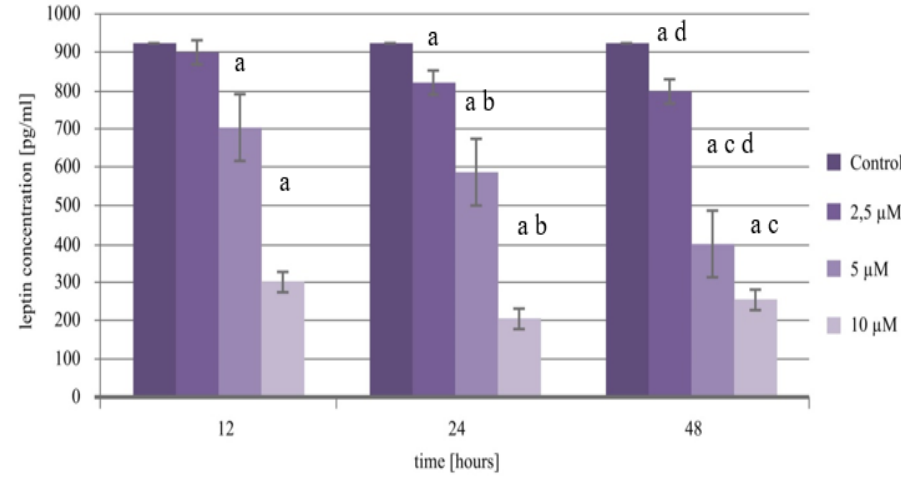
Figure 5. Changes in the expression of leptin in the endometrial cancer cell line treated with cisplatin, obtained by the ELISA assay (a—statistically significant differences in the expression of leptin between cells exposed to cisplatin vs. control p < 0.05; b—statistically significant differences in the expression of leptin between 12 vs. 24 h of exposition of cisplatin p < 0.05; c—statistically significant differences in the expression of leptin between 24 vs. 48 h of exposition of cisplatin p < 0.05; d— cisplatin p <